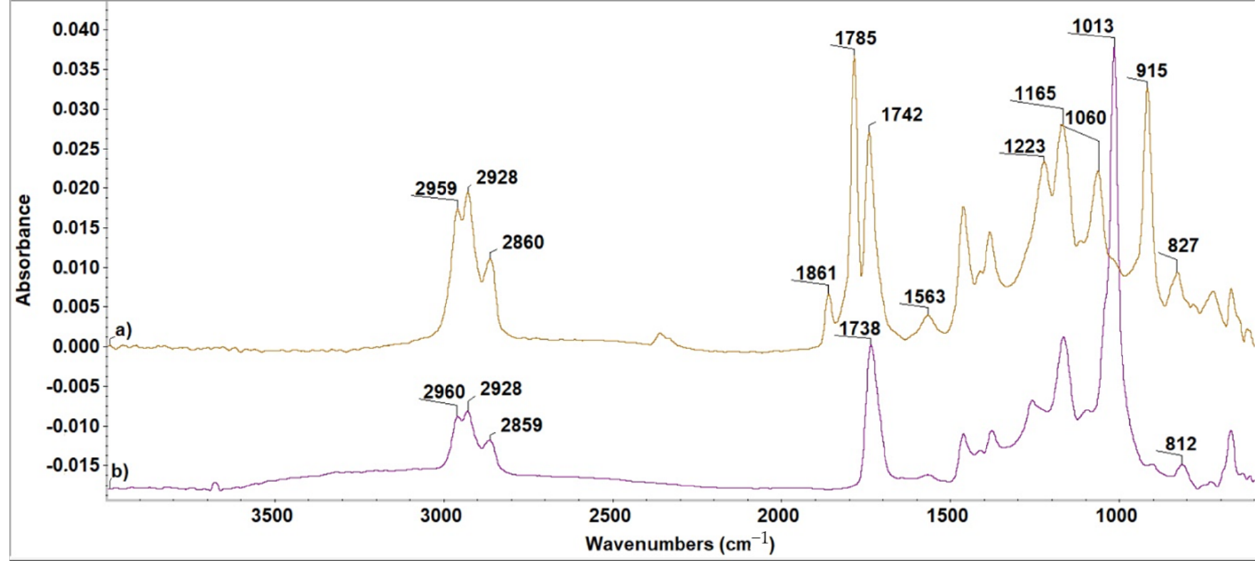
Figure 2. FTIR spectra of the S1 system (ELO + 5%LnK). ( a ) Before and ( b ) after dual-curing reaction.